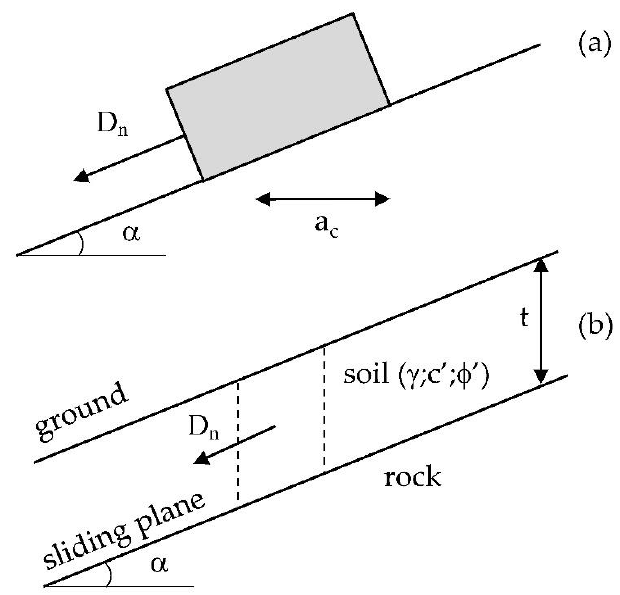
Figure 2. Analogy between the block on the inclined plane and the landslide mass. ( a ) Representation of the Newmark [36] sliding block model; ( b ) infinite slope scheme.